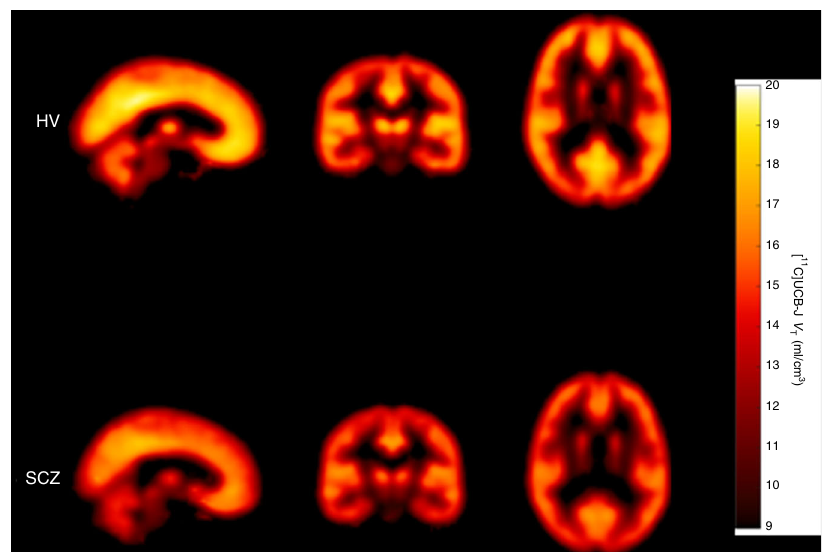
Fig. 2 Mean parametric [ 11 C]UCB-J V T images from healthy volunteer (HV) and schizophrenia (SCZ) groups. Colour bar indicates [ 11 C]UCB-J V T